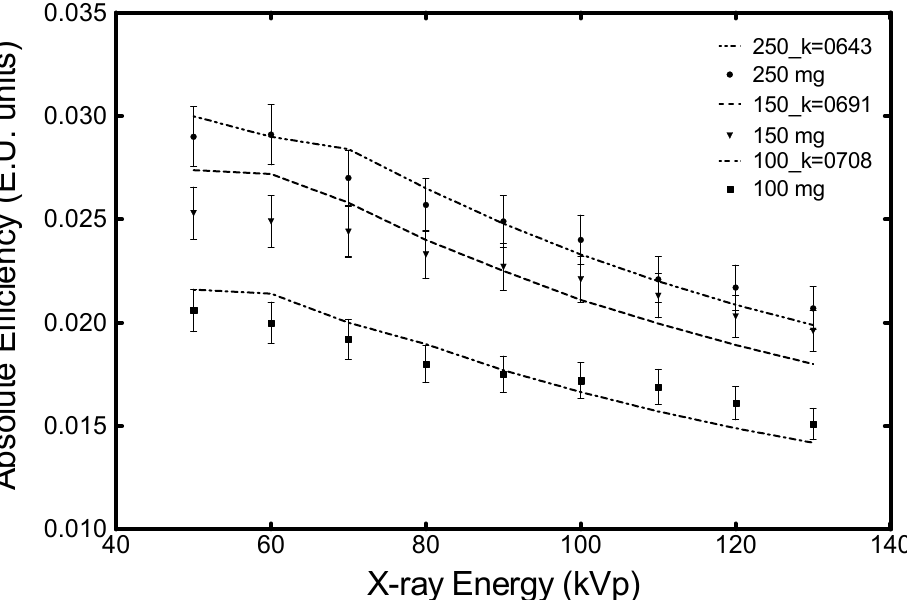
Figure 4. Comparison between experimental and theoretical (based on Equation (5)) absolute efficiency ( AE ) results in E.U. (1 E.U. = 1 μ W m − 2 /mR s − 1 ).